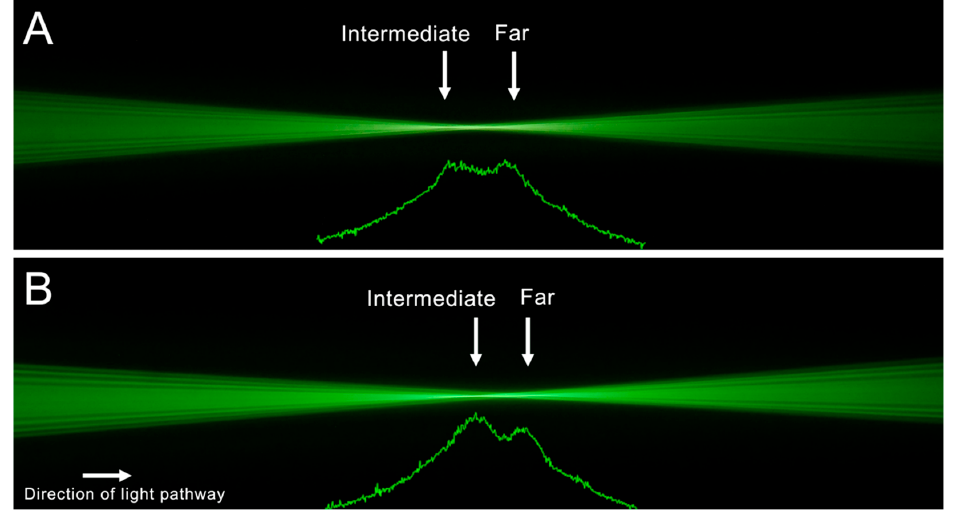
Figure 3. Light-pathways visualization and light intensity profile of the AT Lara ( A ) and Symfony IOL ( B ). Both IOLs showed distinct foci for far and intermediate distances. In the Symfony, a minimally higher light intensity value was found for the intermediate compared to the far